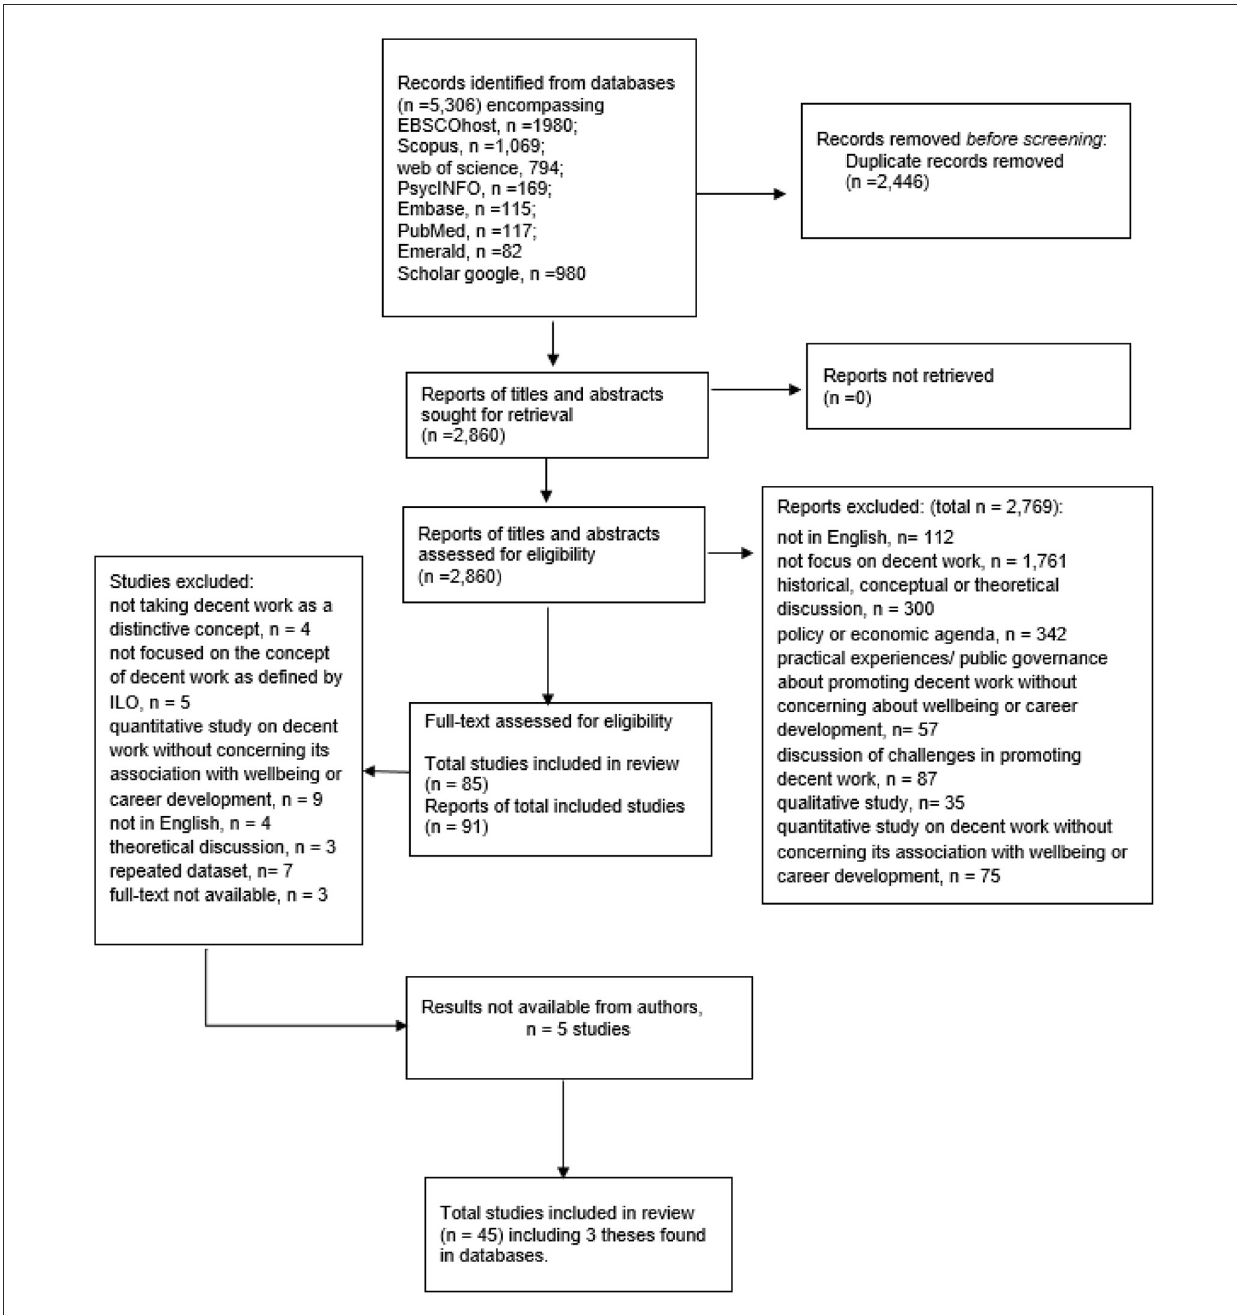
FIGURE1 Flow diagram of the study selection.